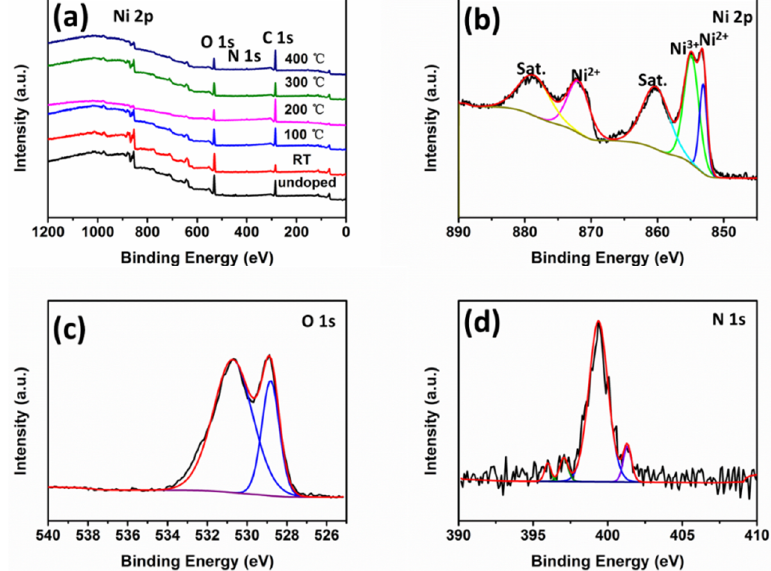
Figure 6. ( a ) XPS survey spectra of NiO films deposited at different substrate temperatures and ( b ) Ni